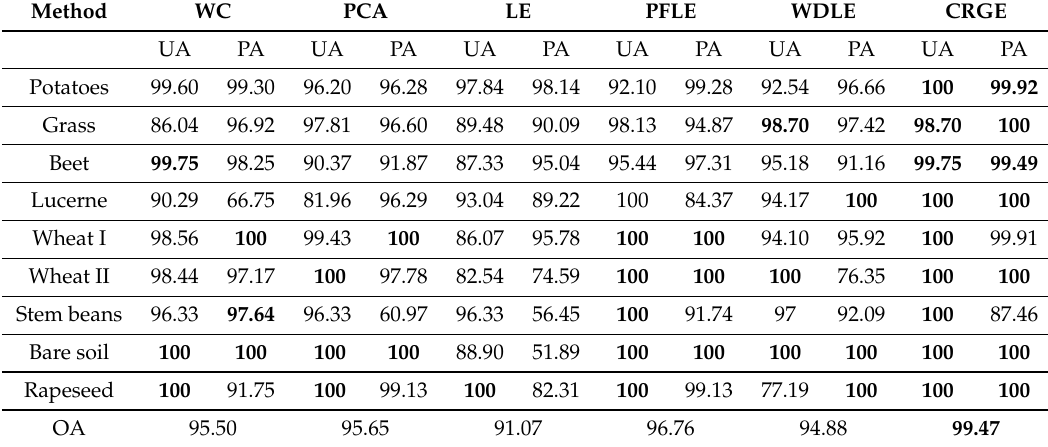
Table 1. Classification accuracies of six methods on the subset of the Flevoland data set.